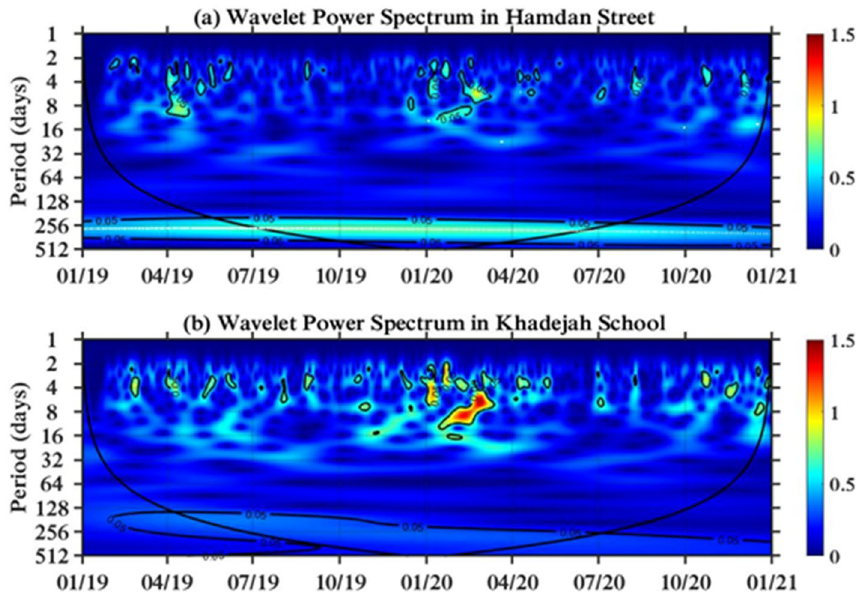
Figure 3. Wavelet power transform in urban areas of the Abu Dhabi capital region: ( a ) Hamdan Street and ( b ) Khadejah